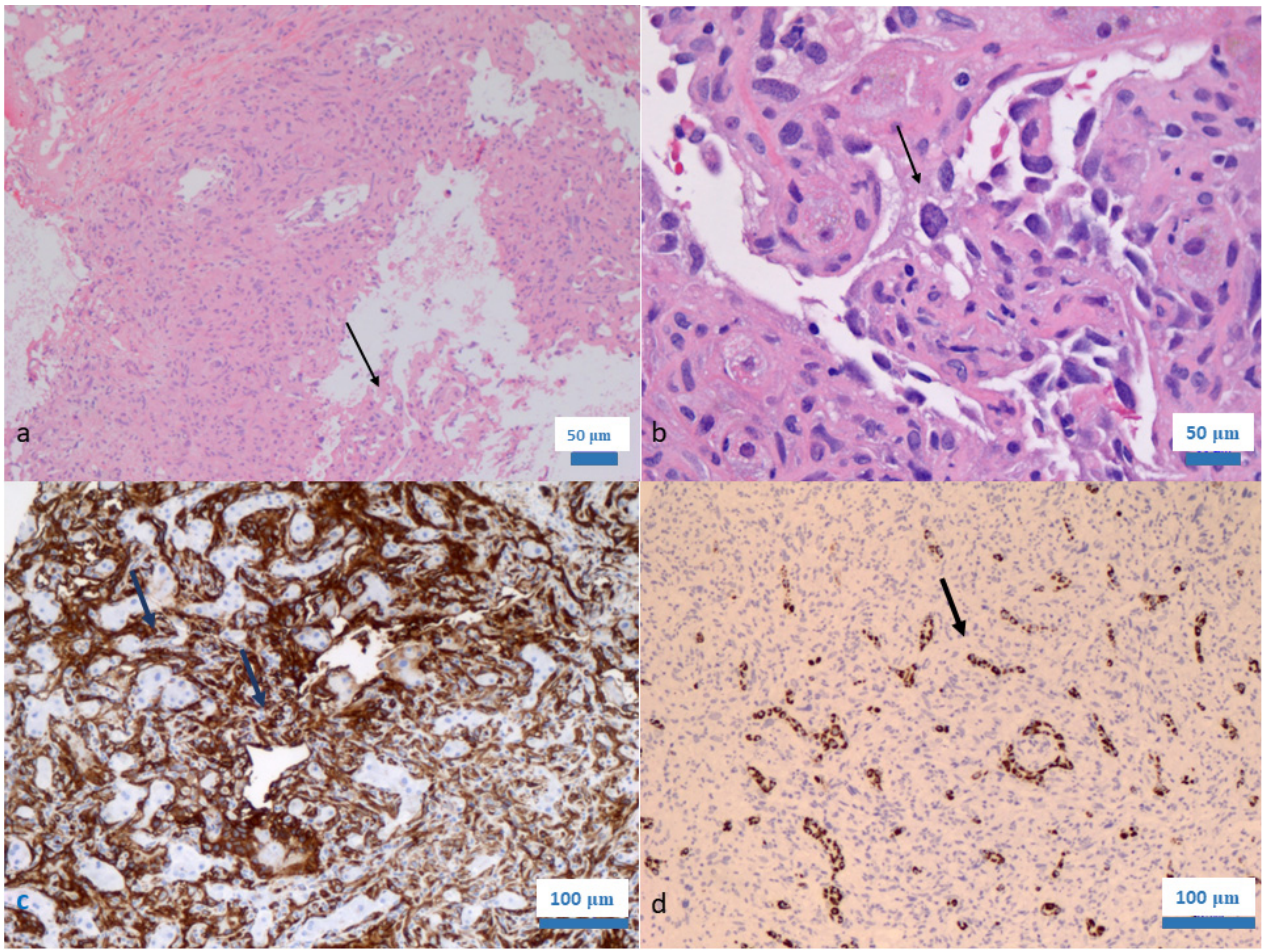
Figure 1. ( a ) Hepatic angiosarcoma of the youth with aggressive infiltration (arrow) of the surround- ing liver parenchyma (hematoxylin and eosin staining; ×100); ( b ) The high power of the hepatic angiosarcoma demonstrated in ( a ) showing vascular channels decorated by atypical mesenchymal cells (arrow) (hematoxylin and eosin staining; ×400); ( c ) Positive expression of CD31 in the tumor cells (anti-CD31 avidin–biotin complex immunohistochemistry; ×200); ( d ) Negative expression of HepPar1 in the tumor cells showing focal expression in the liver cells only (HepPar1 avidin–biotin complex immunohistochemistry; ×200).